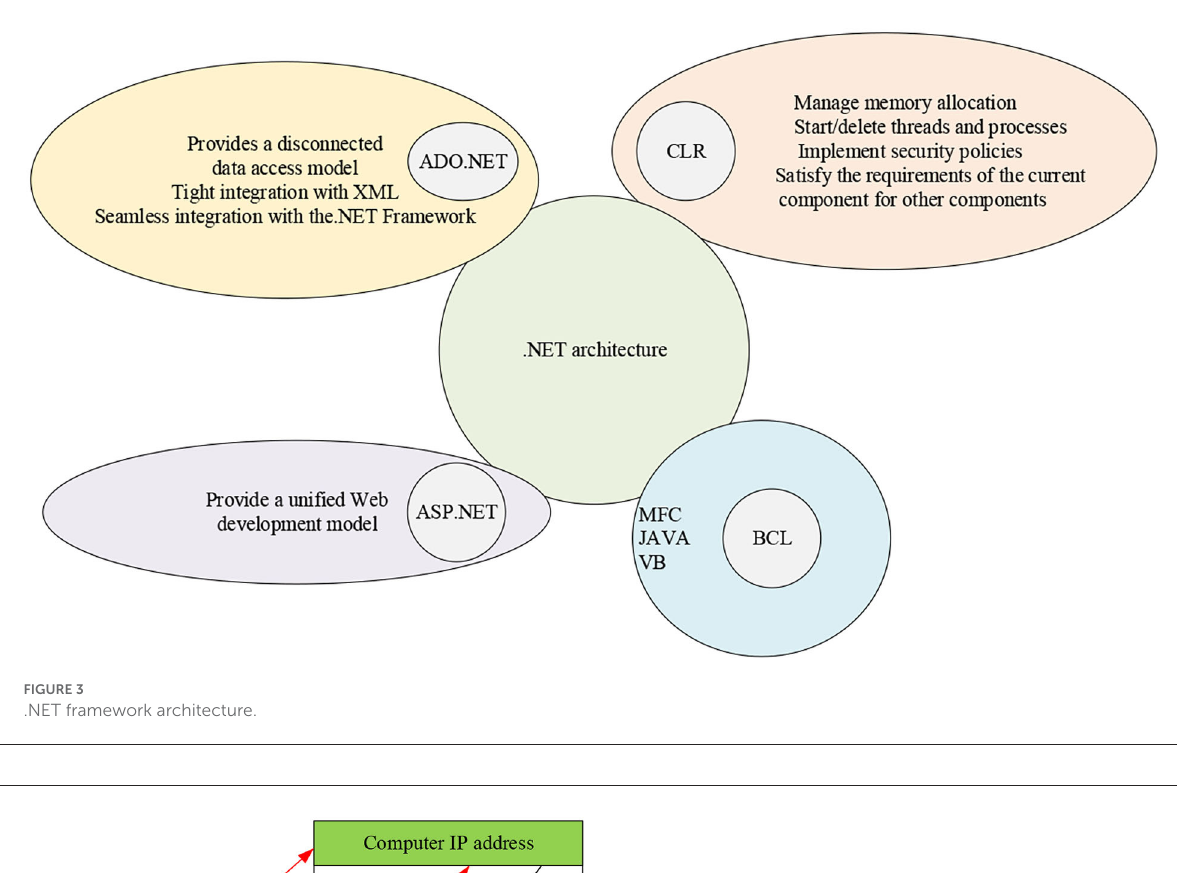
FIGURE3 .NET framework architecture.